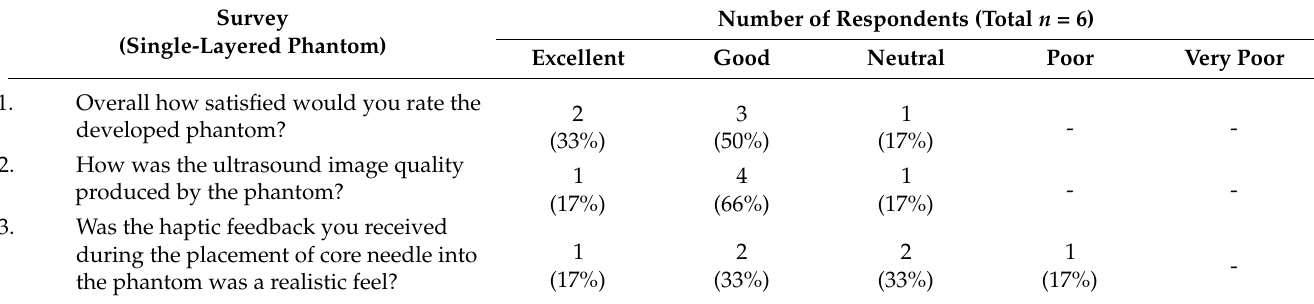
Table 4. Survey on single-layered gelatin-based breast phantom.